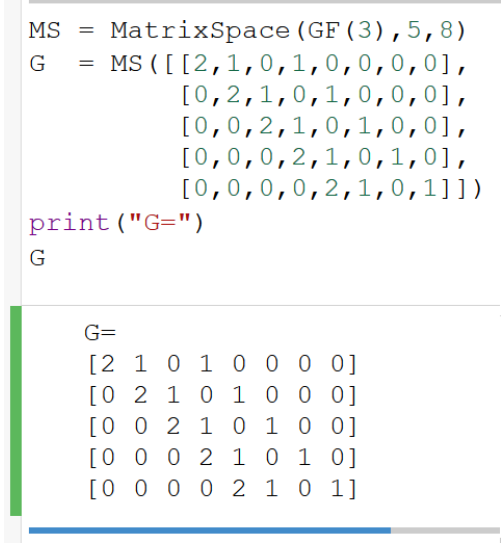
Figure 11. Generator matrix